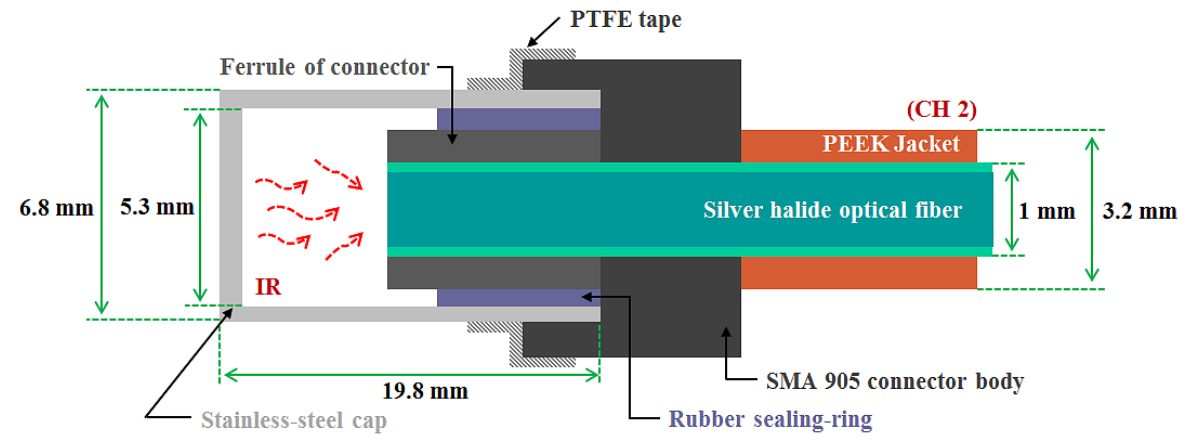
Figure 2. Internal structure of the thermometer